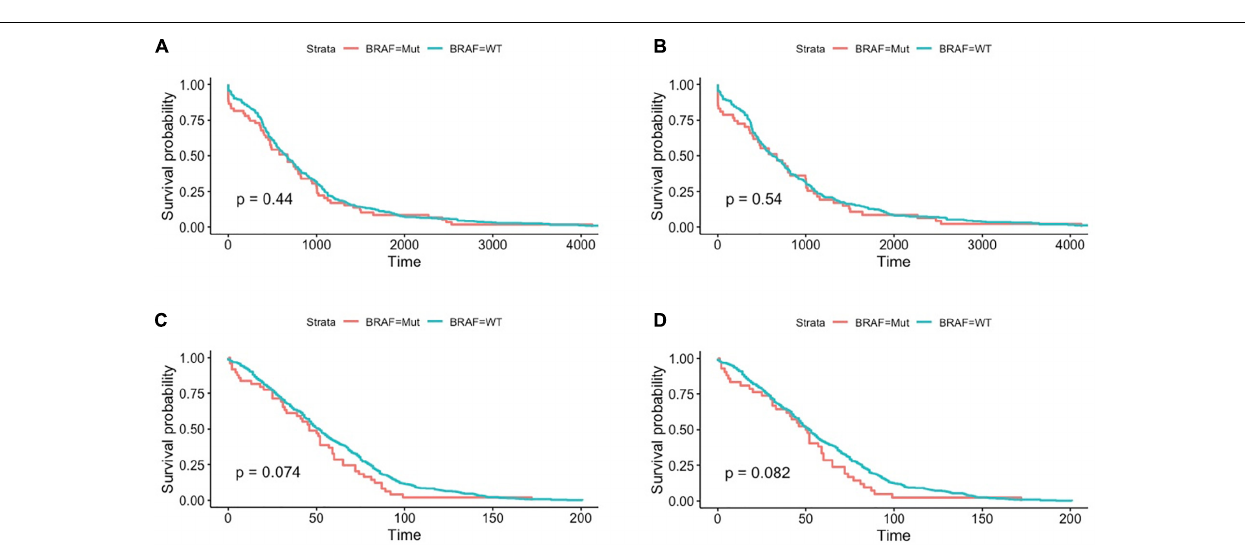
FIGURE 2 | Patients with BRAF mutation had no significant differences in terms of overall survival in the TCGA dataset, as shown in all-stage patients (A) and stage III/IV patients (B) . Similar results were found in GEO datasets, as shown in all-stage patients (C) and stage III/IV patients (D) . Student’s t -tests were used for all